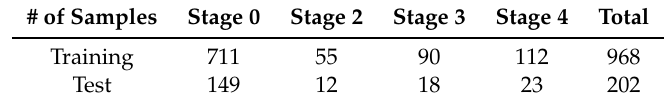
Table 2. Data distribution between the training and test sets by each CLR development